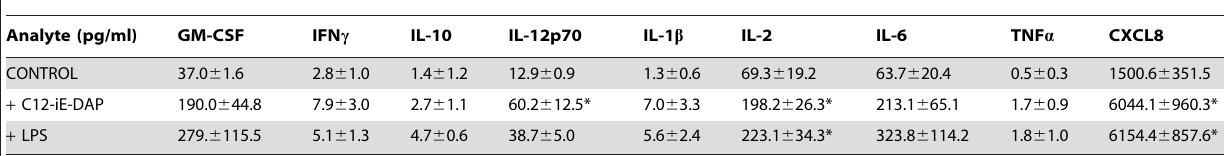
Table 2. MSD analysis of cytokine (pg/ml) release from HUVEC.